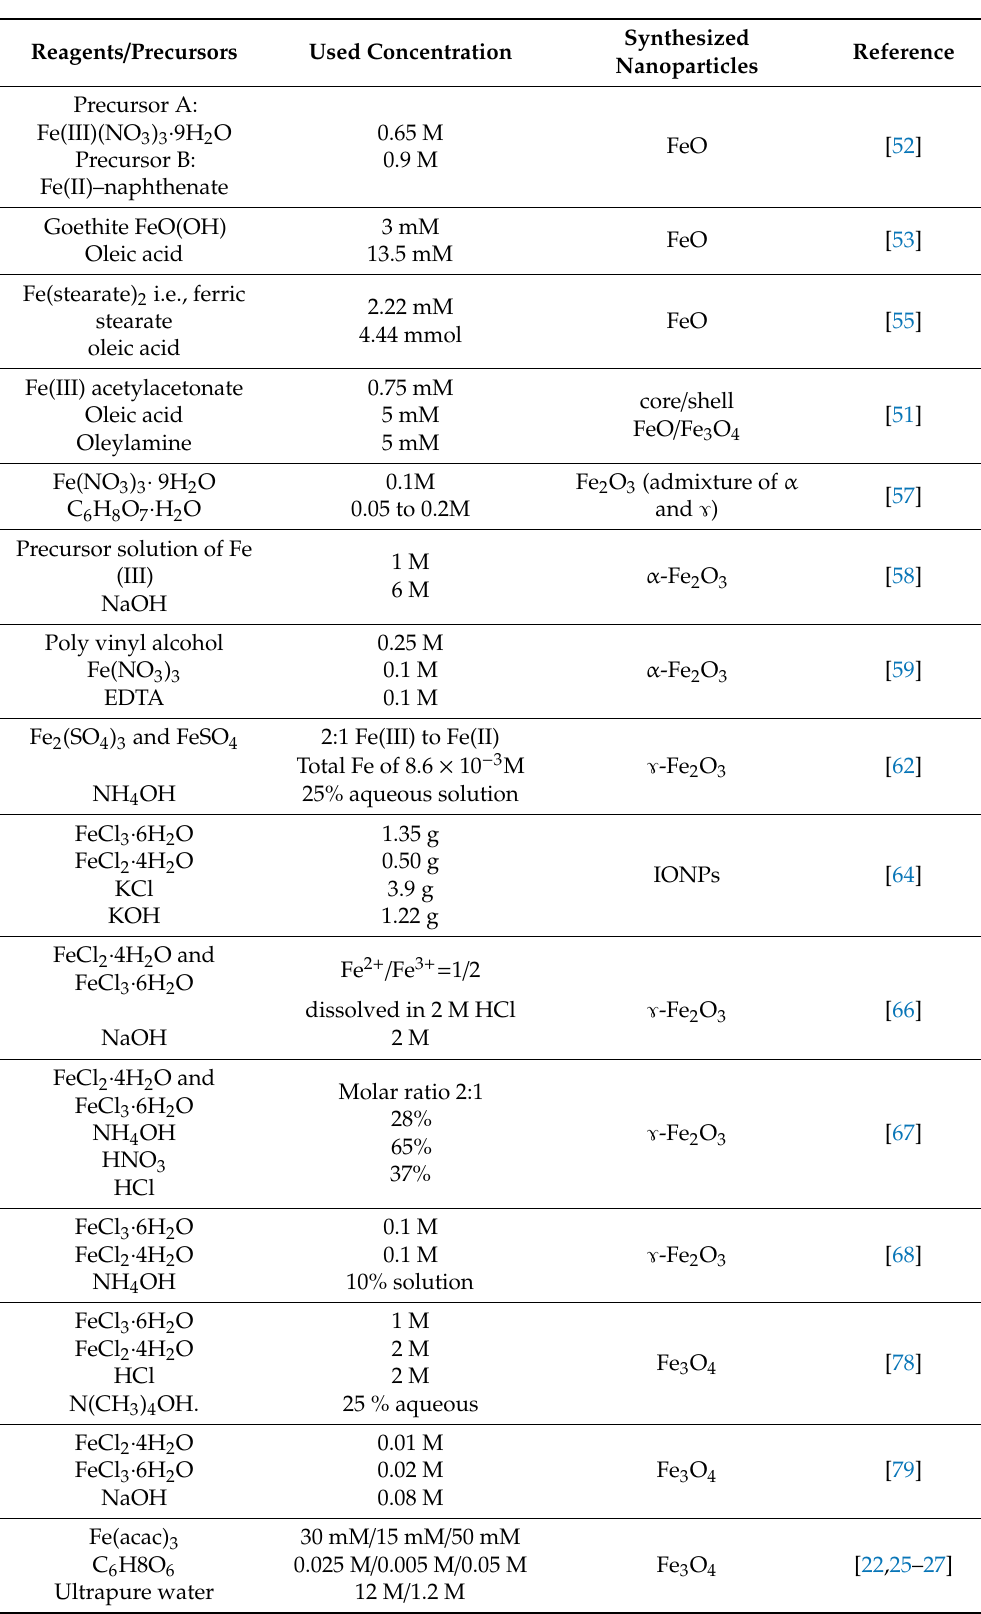
Table 3. Reagents / precursors used in various IONP synthesis